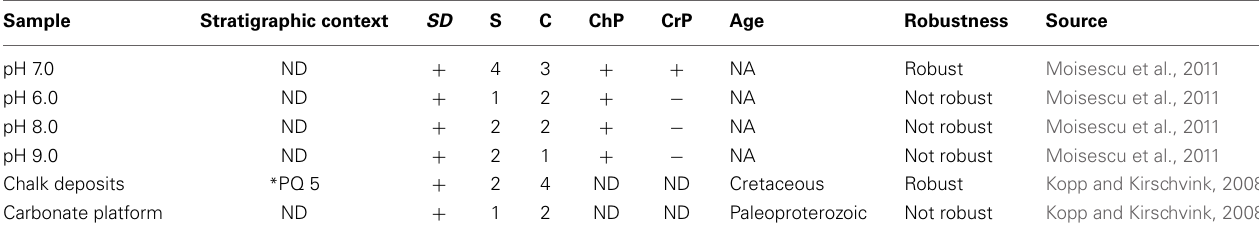
Table 2 | Magnetofossils scores of MTB magnetites that had formed in our cultures (Moisescu et al., 2011) at different pH values.